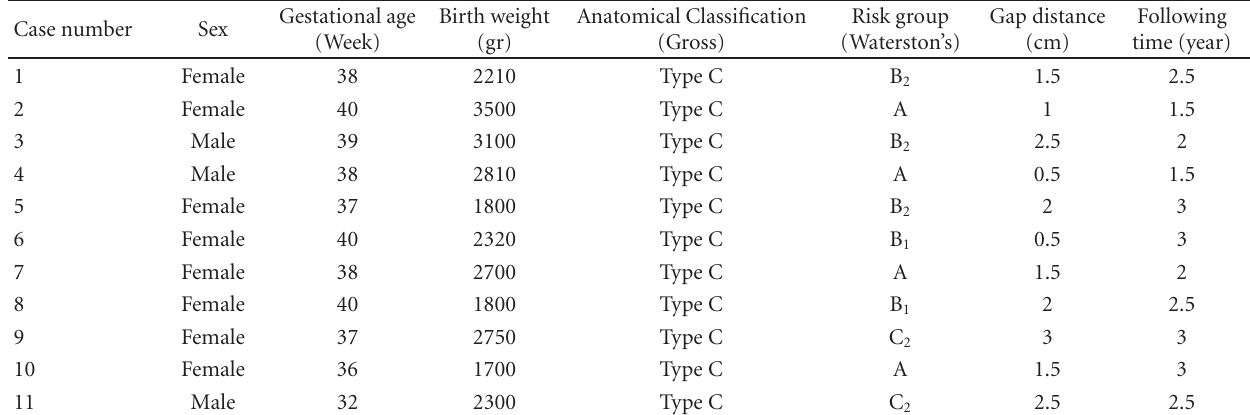
Figure 3: (a) Normal esophageal passage X-ray view of the case with no anastomotic stricture. (b) Nonsymptomatic moderate narrowing and (c) serious anastomotic stricture that caused expansion of the proximal esophagus (another case of our patients). Table 1: Characteristics of